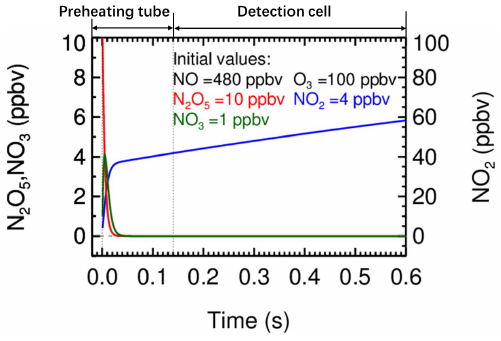
Figure 2. Simulation of the change of the mixing ratios of NO 3 , N 2 O 5 , and NO 2 during the NO titration mode in the preheating tube and detection cell for an extremely high NO 3 and N 2 O 5 case. The initial ambient NO 3 , N 2 O 5 , and O 3 were set at 1, 10, and 100ppbv, respectively. The initial NO 2 was set at 4ppbv from the impurity of the used NO